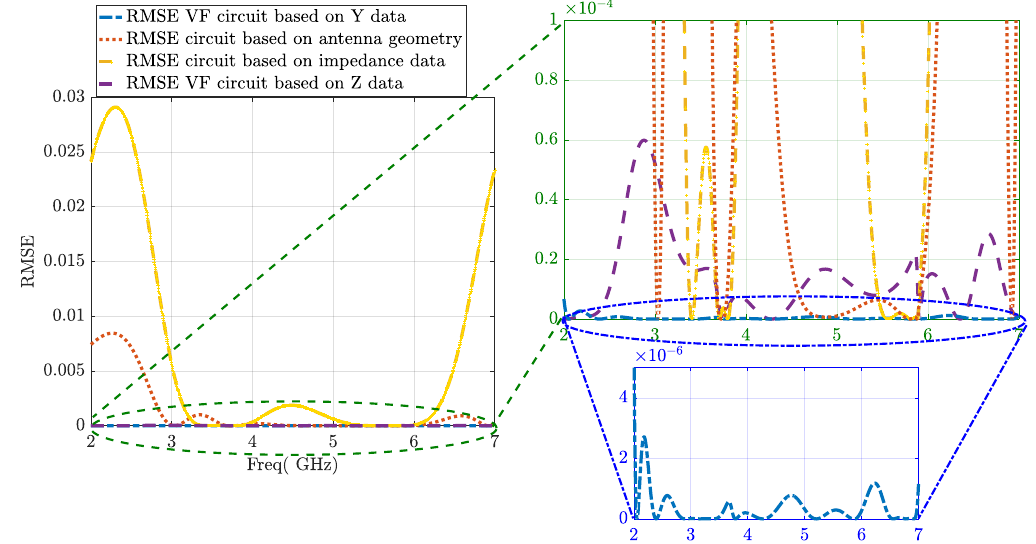
Figure 11 . Comparative study of the RMSE of CST and computed equivalent circuit model results. Figure 11. Comparative study of the RMSE of CST and computed equivalent circuit model